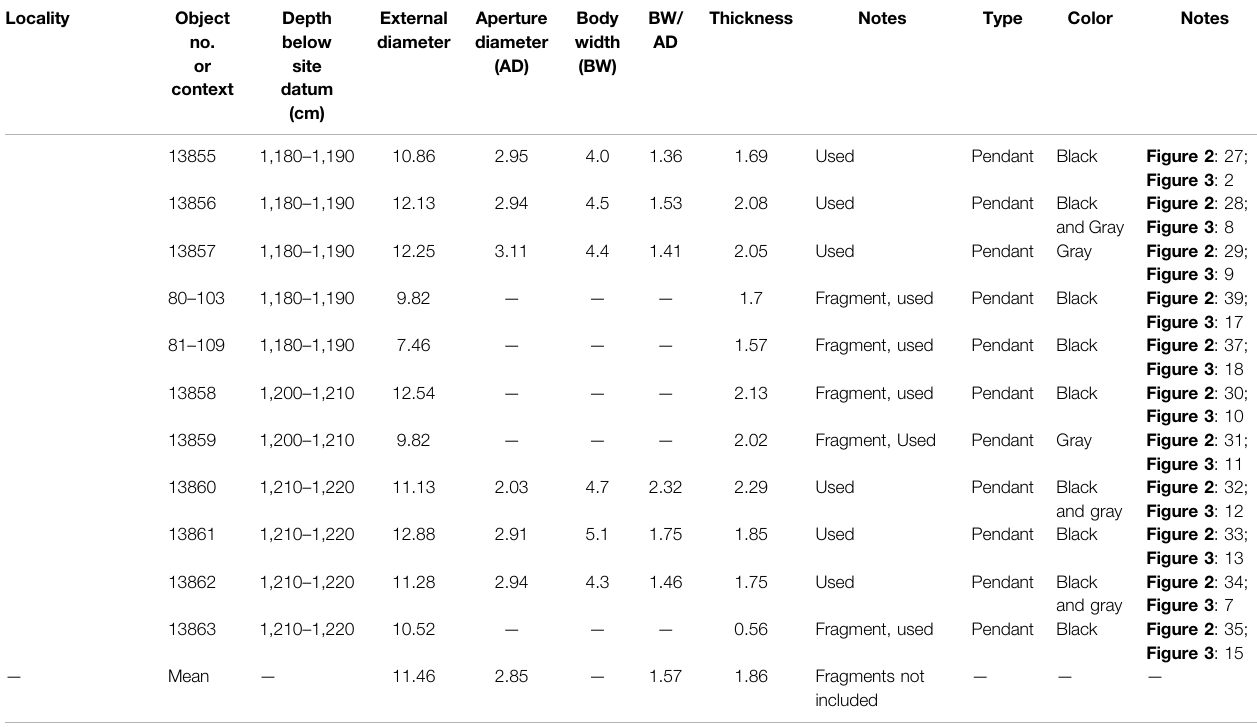
Figure 2 : 27; Figure 3 : 2 Figure 2 : 28; Pendant Black Figure 3 : 8 and Gray Figure 2 : 29; Figure 3 : 9 Figure 2 : 39; Figure 3 : 17 Figure 2 : 37; Figure 3 : 18 Figure 2 : 30; Figure 3 : 10 Figure 2 : 31; Figure 3 : 11 Figure 2 : 32; Pendant Black Figure 3 : 12 and gray Figure 2 : 33; Figure 3 : 13 Figure 2 : 34; Pendant Black Figure 3 : 7 and gray Figure 2 : 35; Figure 3 :